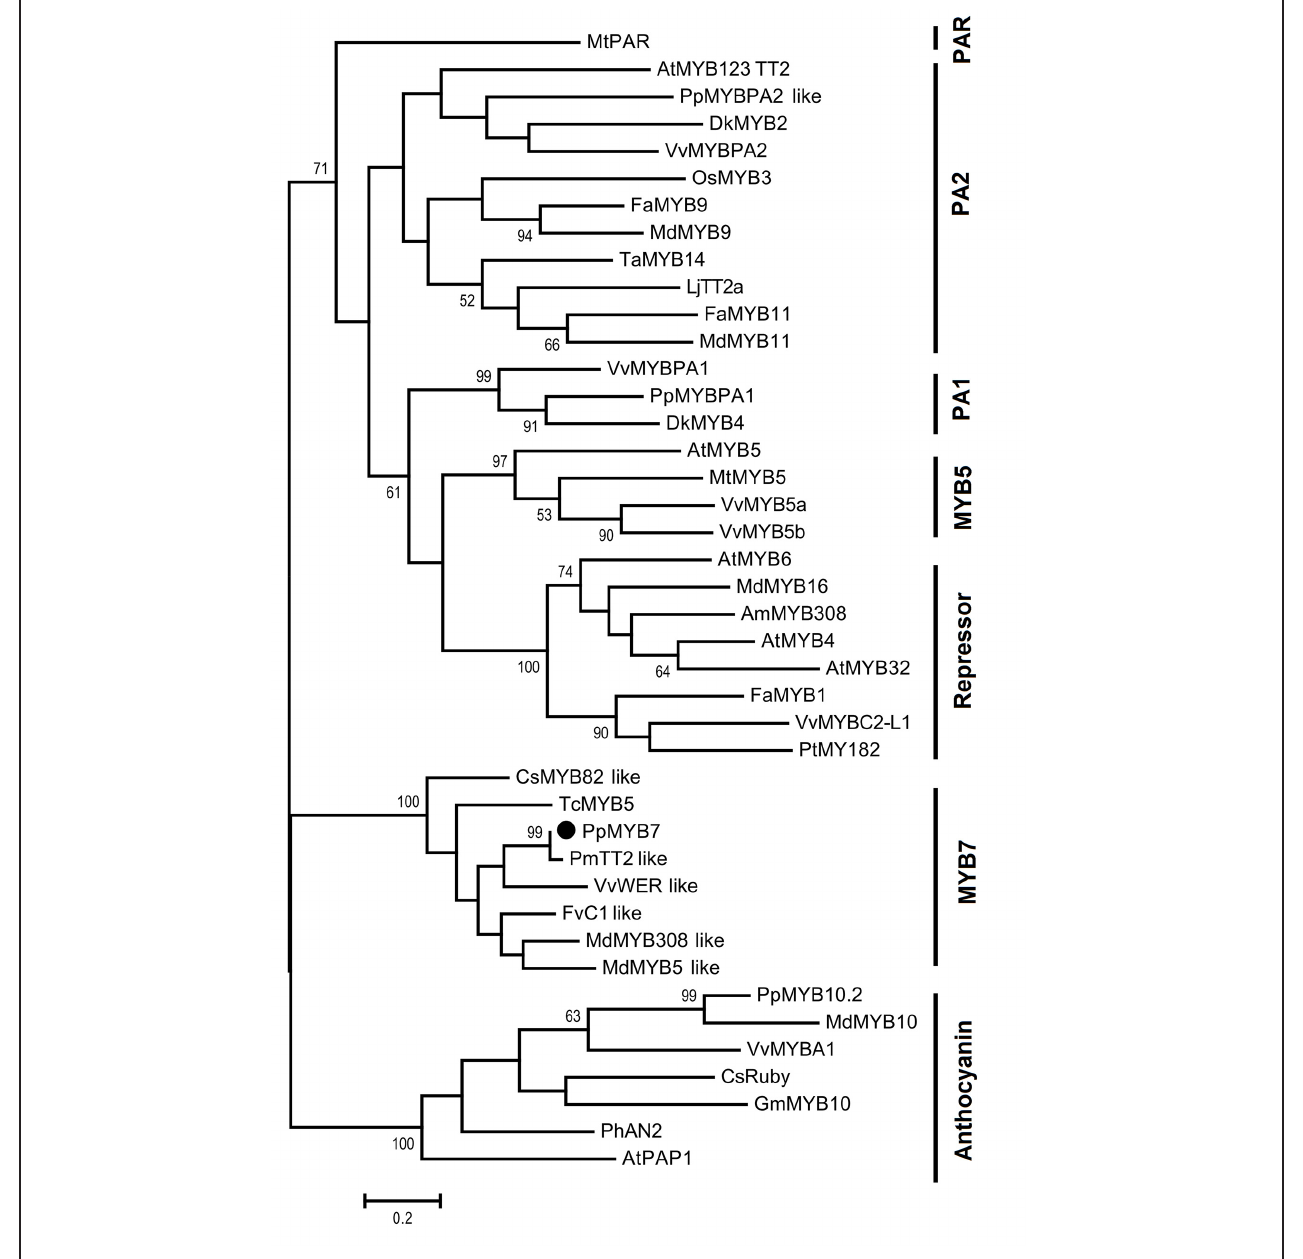
FIGURE 2 | Phylogenetic tree derived from amino acid sequences of genes encoding R2R3-MYB transcription factors. The PpMYB7 gene isolated in this study is highlighted with a black circle. The full length amino acid sequences were aligned using Muscle software and phylogenetic tree was conducted with MEGA version 6.0 using the maximum likelihood method. Numbers on branches represent bootstrap estimates for 1,000 replicate analyses and values < 50% are not indicated. The scale bar represents 0.2 substitutions per site. The GenBank or TAIR accession numbers are as follows: Arabidopsis thaliana AtMYB4 (AT4G38620), AtMYB5 (AT3G13540), AtMYB6 (AT4G09460), AtPAP1 (AT1G56650), AtMYB123 (AT5G35550), AtMYB32 (AT4G34990), Vitis vinifera VvMYBA1 (AB097923), VvMYBPA2 (EU919682), VvMYBPA1 (AM259485), VvMYB5a (AAS68190), VvMYB5b (AAX51291), VvMYBC2-L1 (JX050227),